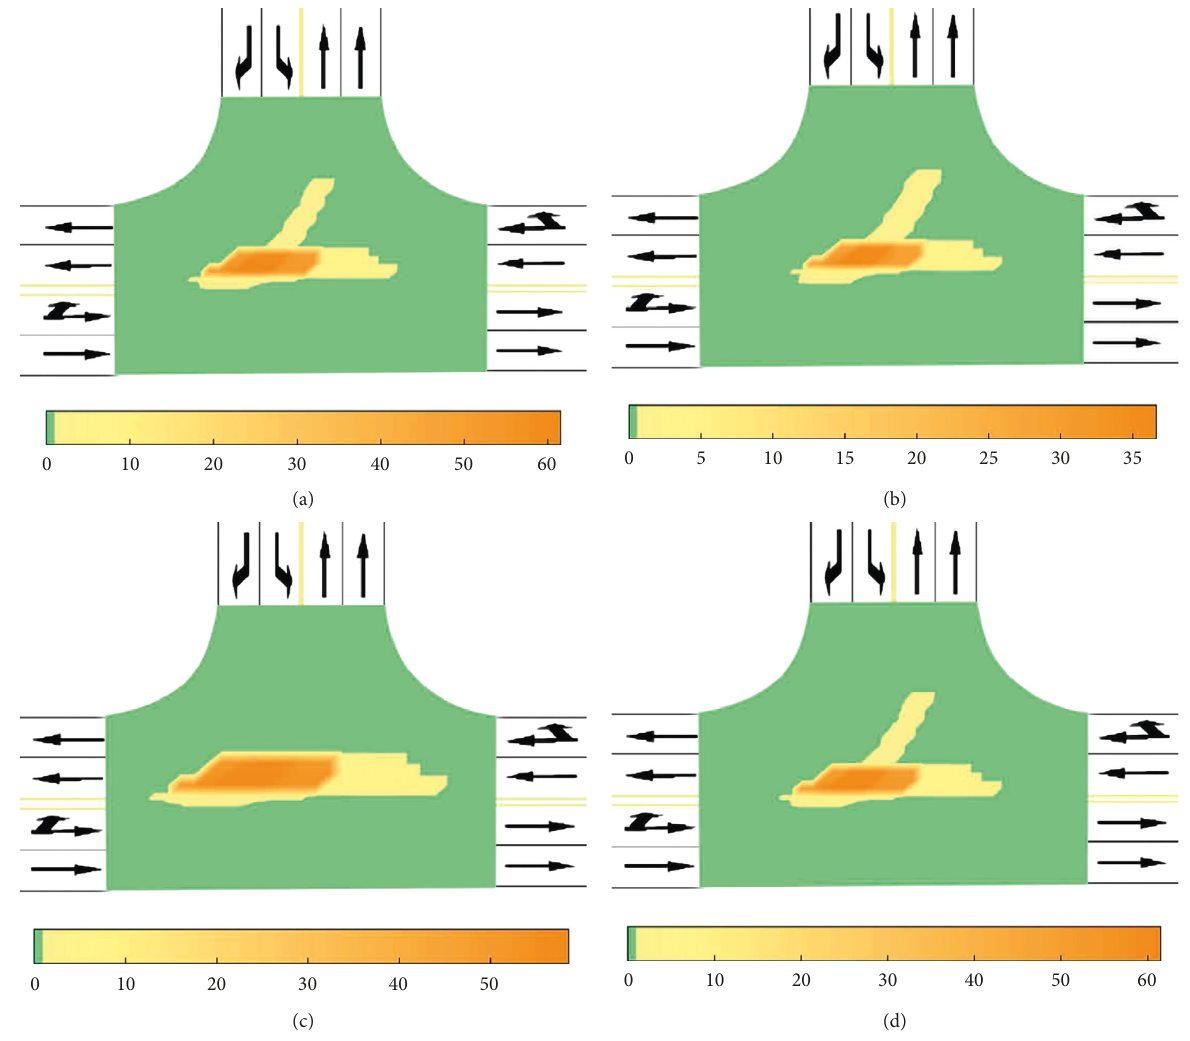
Figure 10: The heat maps of conflict times of intersection under different flow control schemes. (a) Existing scenario. (b) Scenario 1. (c) Scenario 2. (d) Scenario 3.